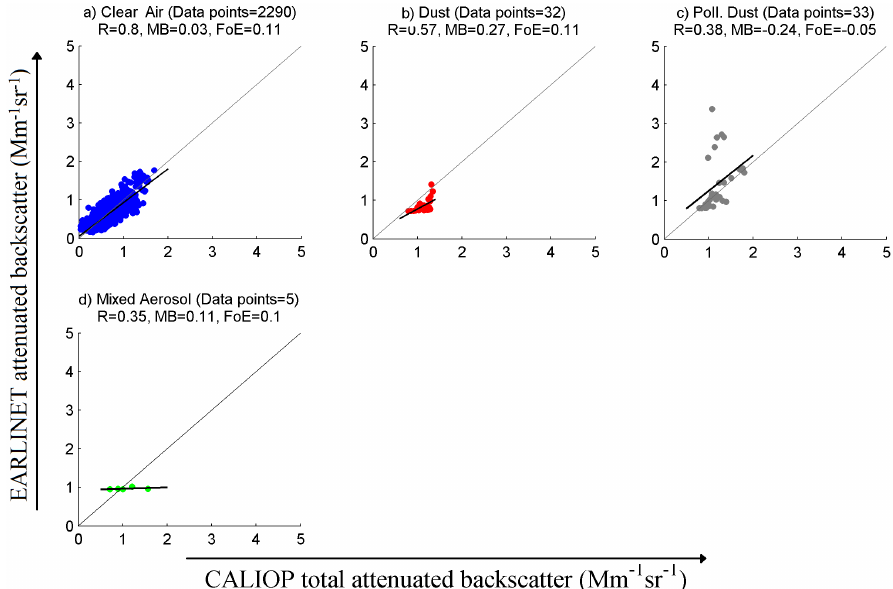
Figure 13. Four Level 1.5 feature types for CALIOP overpasses over EARLINET stations for the FT. The plot includes filtered data points for overpasses without layers present in both the PBL and the